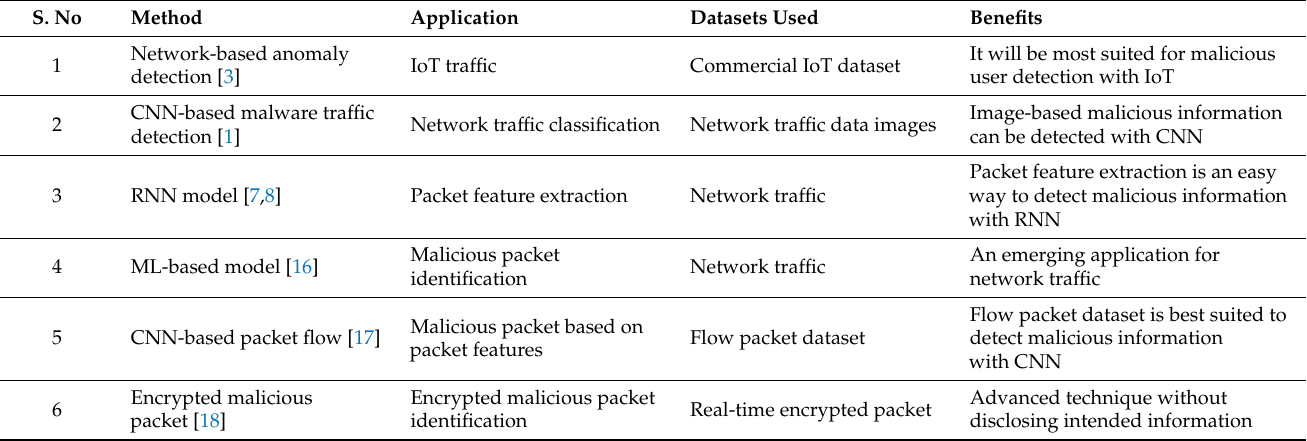
Table 2. Work related to various methods for detecting malicious